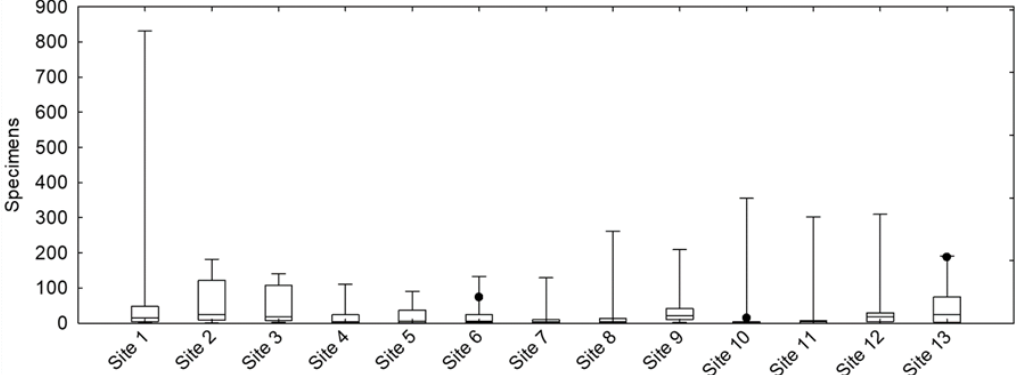
Figure 5. Box plots of Silphidae recorded in all investigated sites. The thick horizontal lines within the boxes indicate median values. On each box, the bottom and top edges of the box indicate the 25th and 75th percentiles, respectively. Small black circles are outliers.